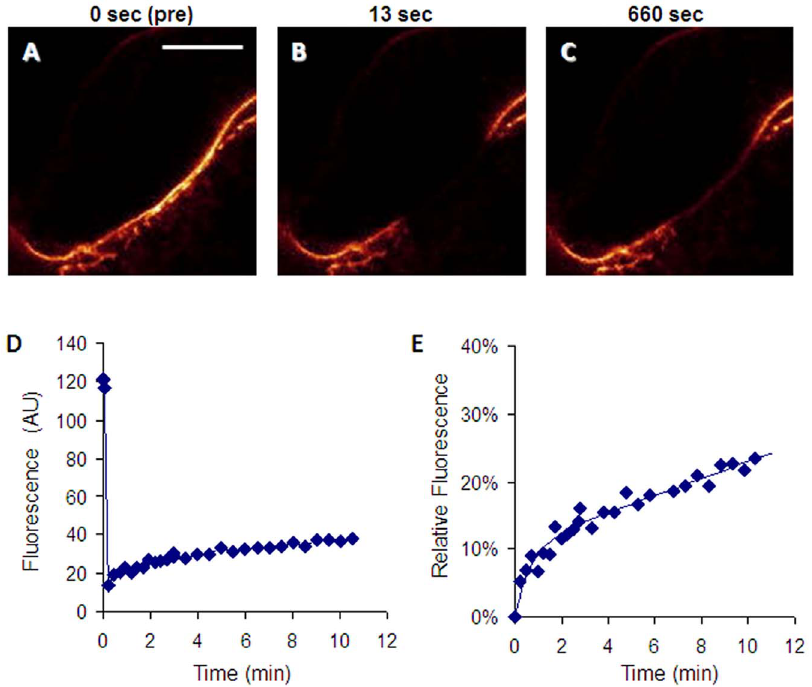
Figure 2. Assessment of canalicular trafficking of ABCB11 by FRAP in mouse hepatocytes. ( A–C ) Primary hepatocyte cultures were transduced with adenovirus containing YFP-tagged ABCB11 on day 3. Fluorescence recovery after photobleaching (FRAP) was studied 3–5 days after transduction. A segment of the canalicular membrane was photobleached on the basis of YFP fluorescence, which was continuously monitored by confocal imaging. Elapsed times after photobleaching are indicated on the top of the pseudocolored images. Scale bar 10 m m. ( D ) Raw kinetics of fluorescence recovery measured in the photobleached membrane segment. ( E ) Fluorescence recovery curve was double normalized, and only the postbleach period was considered for kinetic analysis. The obtained data points were fitted as described in the text.